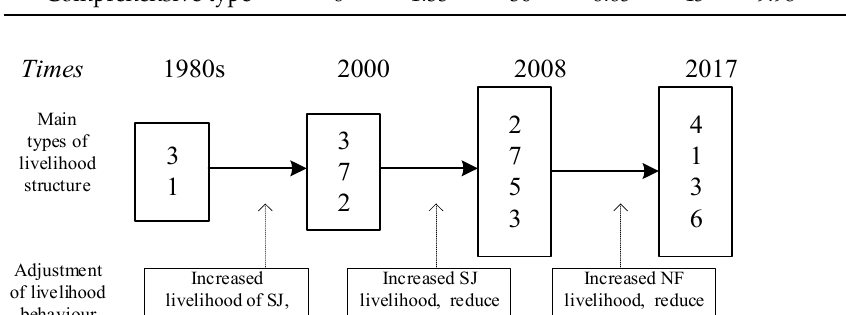
Figure 6. Transition of households’ livelihood structure caused by livelihood behaviors since 1980s.